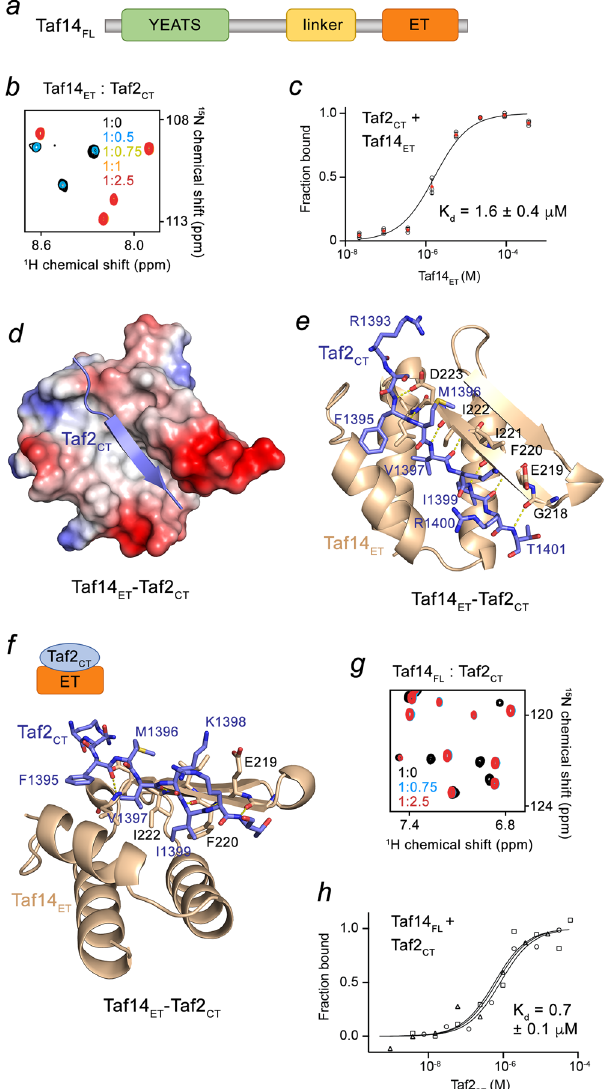
Fig. 1 Structural mechanism for the interaction of Taf14 ET with Taf2 CT